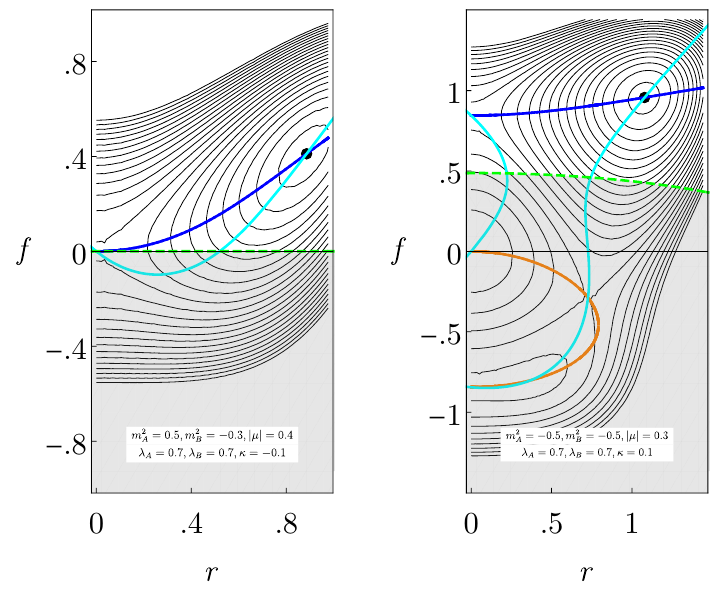
Figure 2 . EFT submanifolds in the Abelian toy model obtained by matching in the unitary basis and the mass basis for two representative sets of parameters, one with m 2 > 0 (left panel) and the A other with m 2 < 0 (right panel). In each panel, contours of the potential eq. (7.6) are shown in the A ( r, f ) plane in arbitrary mass units with the indicated choice of parameters. We fix β = − arg µ + π . The location of the global minimum is denoted by a black dot, while the fixed point corresponds to ( r, f ) = (0 , 0) . The EFT submanifold branches obtained by matching in the unitary basis are shown in blue and orange; blue corresponds to solution(s) of ∂V = 0 in regions where the UV fluctuations ∂f (in f and β ) have positive definite mass matrix, and orange is for the opposing case. The region in which the UV fluctuations do not have positive definite mass matrix is shown in light gray, with a dashed green boundary. The EFT submanifolds obtained by matching in the mass basis are shown in cyan, corresponding to the solutions ∂V = 0 . In the left panel, the choice of parameters (namely ∂H m 2 > 0 ) admits a SMEFT, as illustrated by the existence of an EFT submanifold connecting the A UV fixed point to the global minimum through a region where the mass matrix is positive definite. In the right panel, the choice of parameters (namely m 2 < 0 ) requires a HEFT, as none of the EFT A submanifolds connect the fixed point to the global